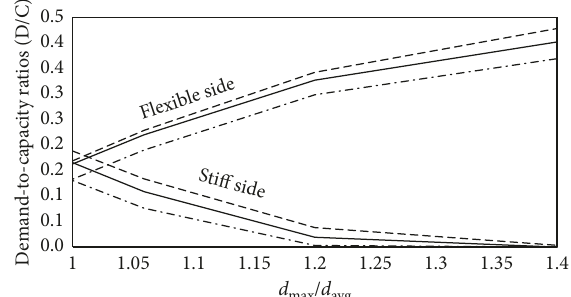
Figure 13: Demand to capacity ratios D/C, calculated by means of nonlinear dynamic analyses, at varying δ max / δ avg provided by equivalent linear static analysis. Comparison between the inelastic response of the column placed on the stiff side and that provided by the column on the flexible side.